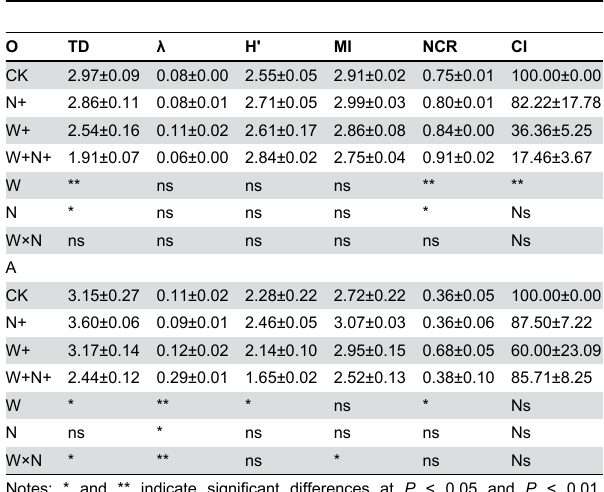
Table 2. Nematode ecological indices among different N and water addition treatments.